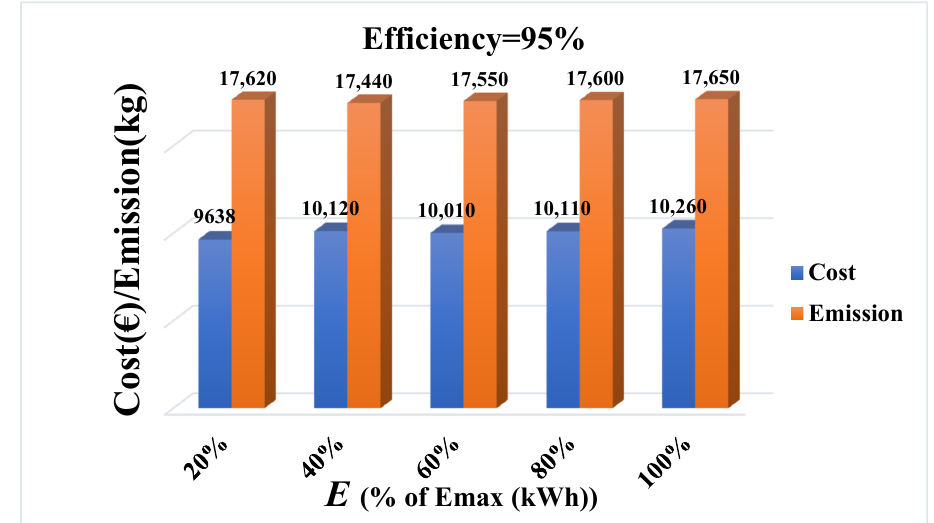
Figure 7. Cost and emission of the BCS in different initial charge values for 93% efficiency.